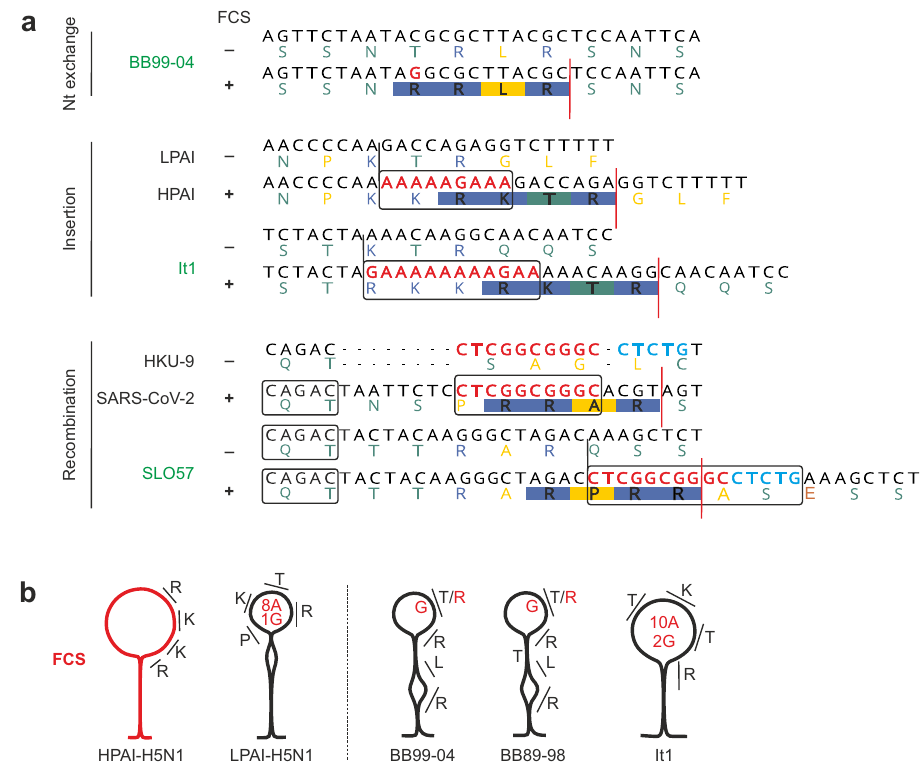
Fig. 4 Predictive acquisition of furin cleavage sites in European bat SARS-related coronaviruses through different molecular mechanisms. a Potential generation of FCS in different European bat SrC by nucleotide exchange, insertion due to external stem loop structures or recombination with HKU9 (15 nucleotides, 10 of which occur identically in SARS-CoV-2). Sequences of BB99-04 and It1 were trimmed in the fi gure for graphical reasons to highlight the FCS. The complete sequences used for FCS prediction were AKYGISSNRRLRSNSQSIV for BB99-04 and AKFGSTRKKRKTRQQSIL for It1. b Simpli fi ed predicted RNA secondary structures of the polybasic cleavage site regions of AIV and SrC that acquire FCS through nucleotide substitutions or insertions. Amino acids corresponding to codons forming the FCS are shown. Nucleotides and corresponding amino acids that make a change to an FCS through nucleotide substitutions or insertions are marked in red. Corresponding structures showing complete nucleotide sequences are shown in Supplementary Fig. 2. Table 2 Single nucleotide variants within two European SrC at spike position Thr672 a .